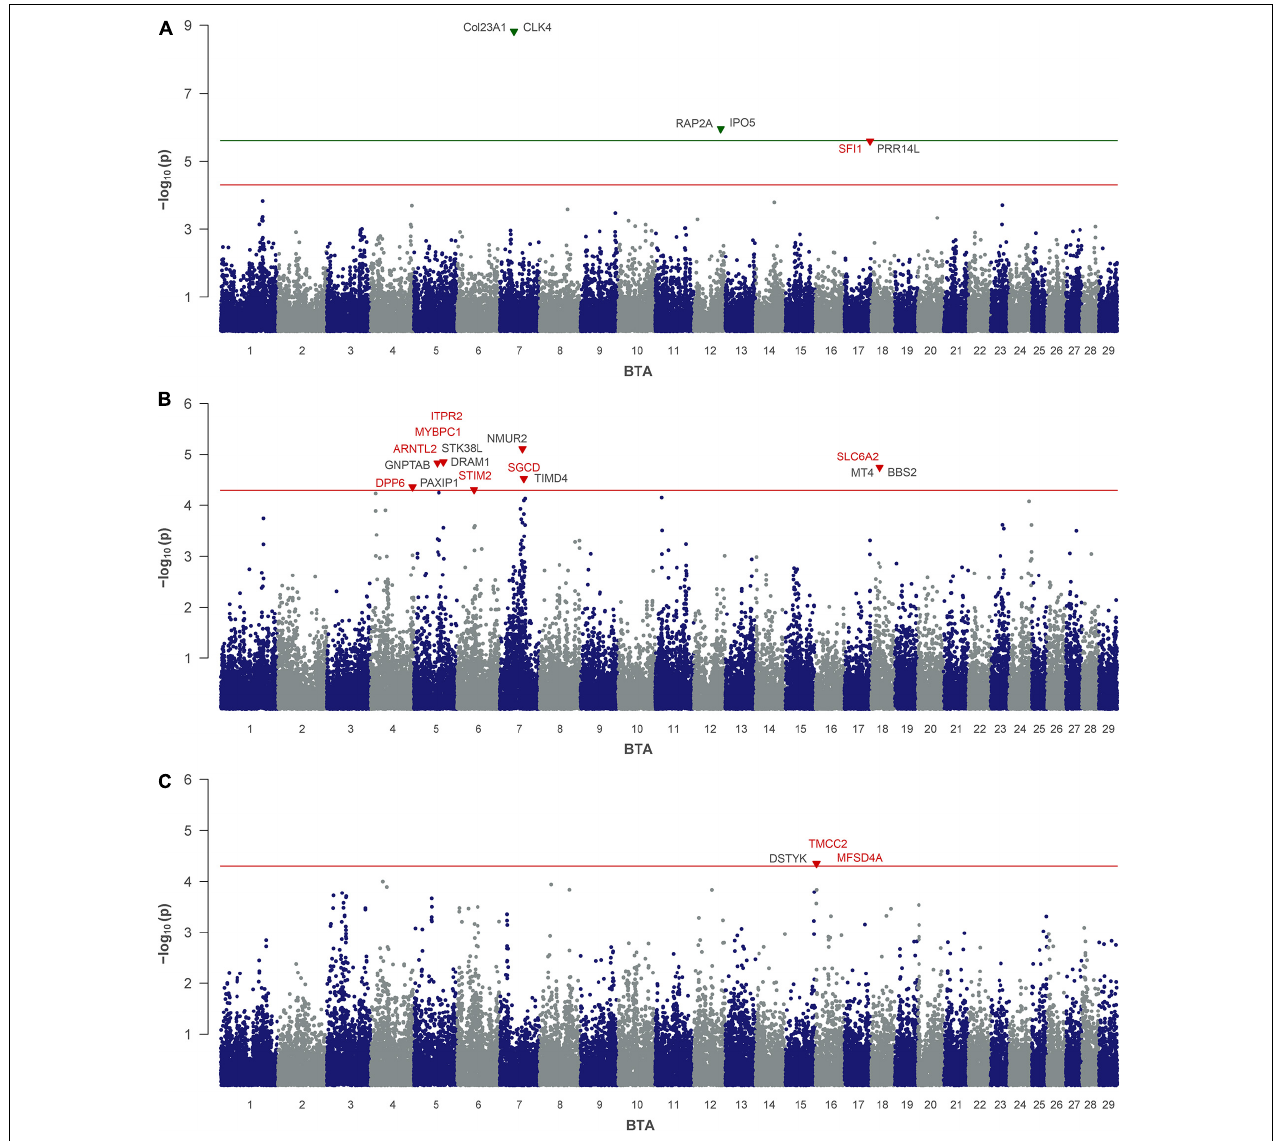
FIGURE 3 | Genome-wide association analysis of non-urea-nitrogen traits: (A) hippuric acid, (B) creatine and (C) creatinine. The red and green lines indicate suggestive and genome-wide significance thresholds, respectively. Genes with a suggested positional or biological association to the trait are indicated in red. Genes, located closest to the right and left of the lead SNP in a 1-Mb window are colored in